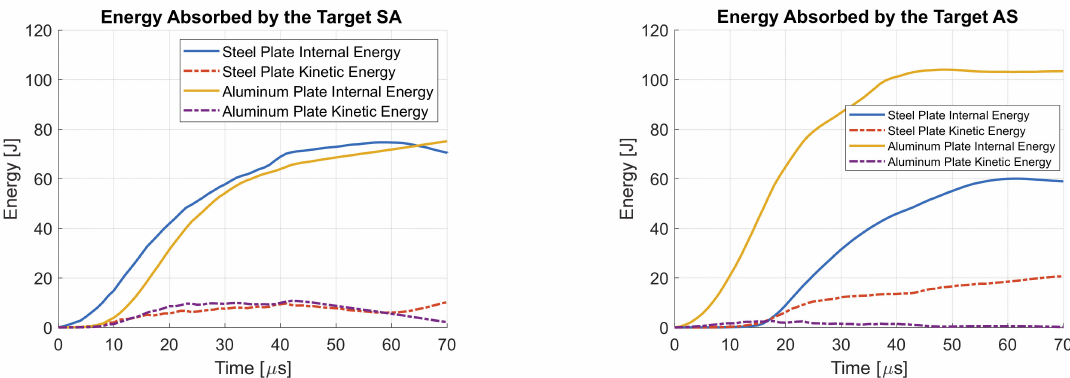
Figure 17. Energy absorbed by the target SA ( a ) and AS ( b ) at 820 m/s impact